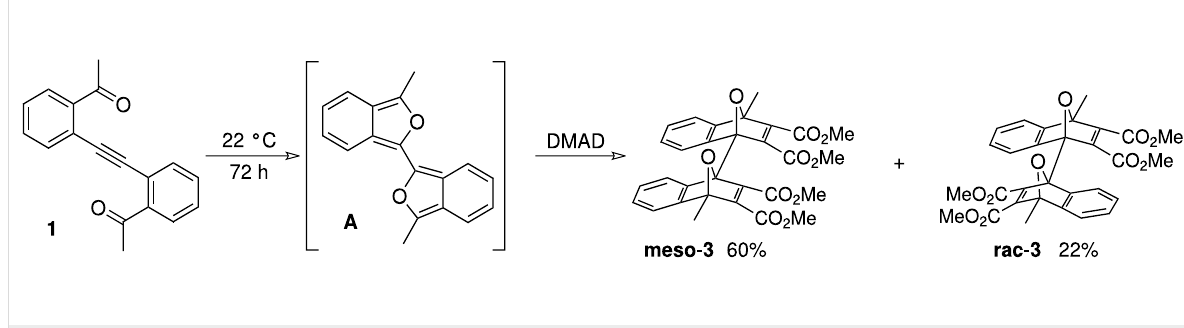
attack of a carbonyl oxygen on the near carbon of the alkyne produces intermediate B (Scheme 7). This attack might be cata- lyzed by protonation of a carbonyl by adventitious acid. The enolate (or enol) oxygen of B would then attack the central carbon of the allene, closing the second ring and forming biisobenzofuran A .